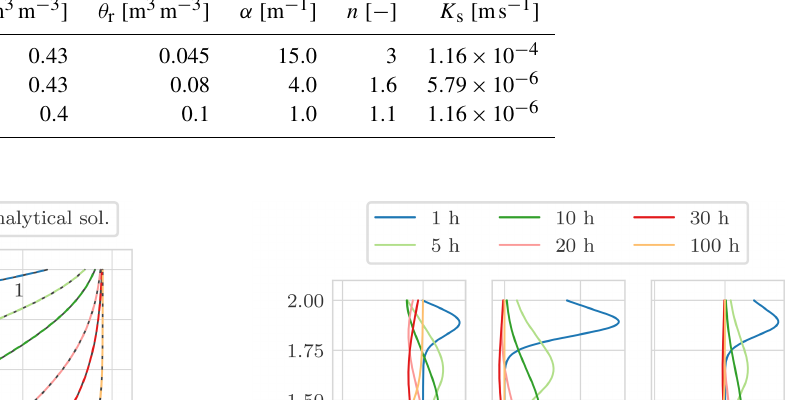
Table C1. Hydraulic properties for the three soil types used in the Vanderborght test case (TP3). Soil type